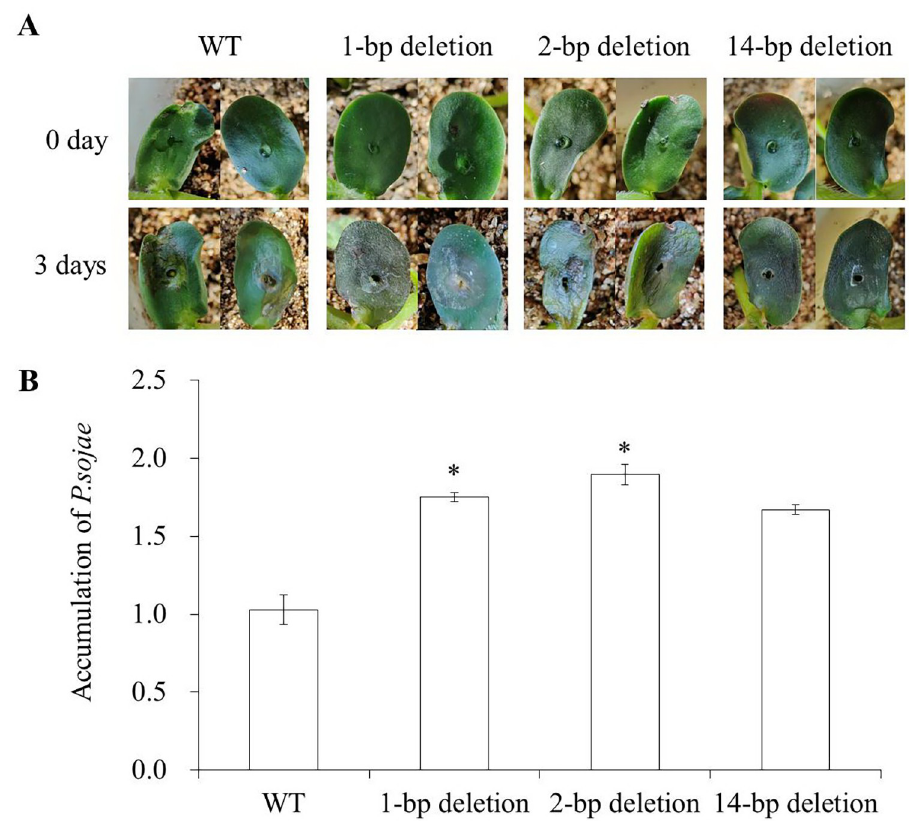
Fig 4. Phenotypes of T1 mutants in response to P . sojae infection. (A) Disease symptoms on the cotyledons of T1 tcp19l mutants and WT treated with P . sojae after 3 days. (B) Accumulation of P . sojae in tcp19l mutants and WT. Three independent biological replicates were used for each sample and the student’s t -test ( � P < 0.05) was used to analyze statistical significance. Error bars represent ±